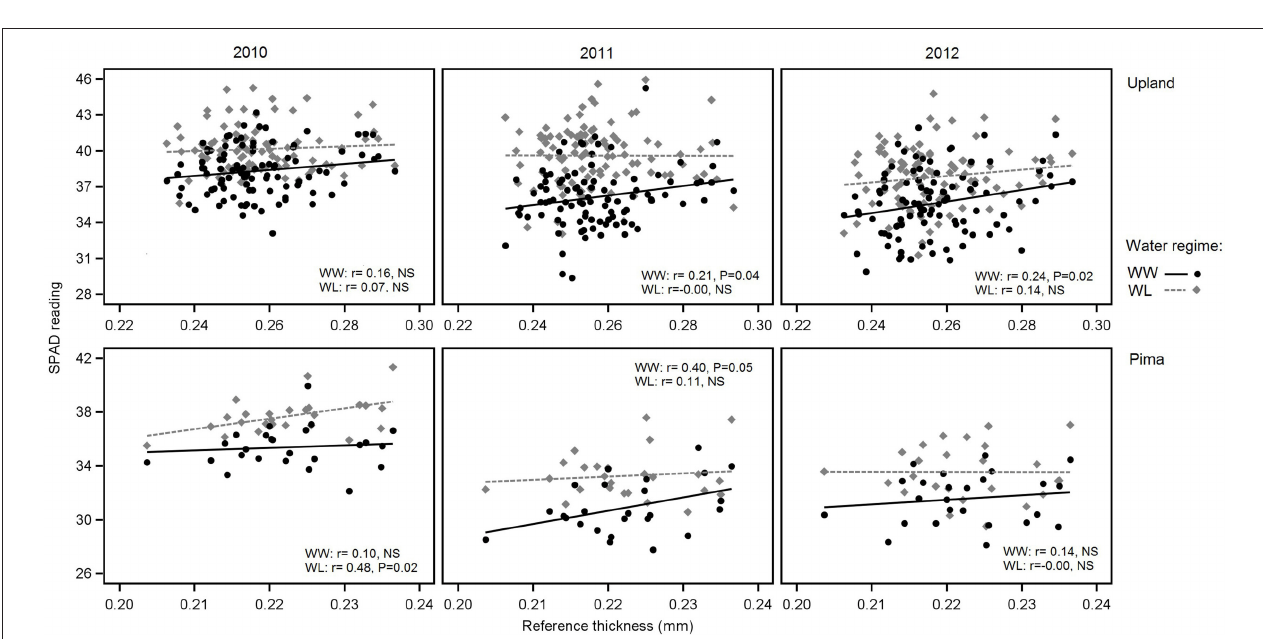
FIGURE 4 | Variation in SPAD readings in relation to reference leaf thickness for 2010, 2011 and 2012 and the two irrigation regimes. The upper three graphs are for upland RILs, and the lower three are for the Pima diversity panel. Lines indicate regression trends for each irrigation regime. Note difference in scales for upland vs. Pima